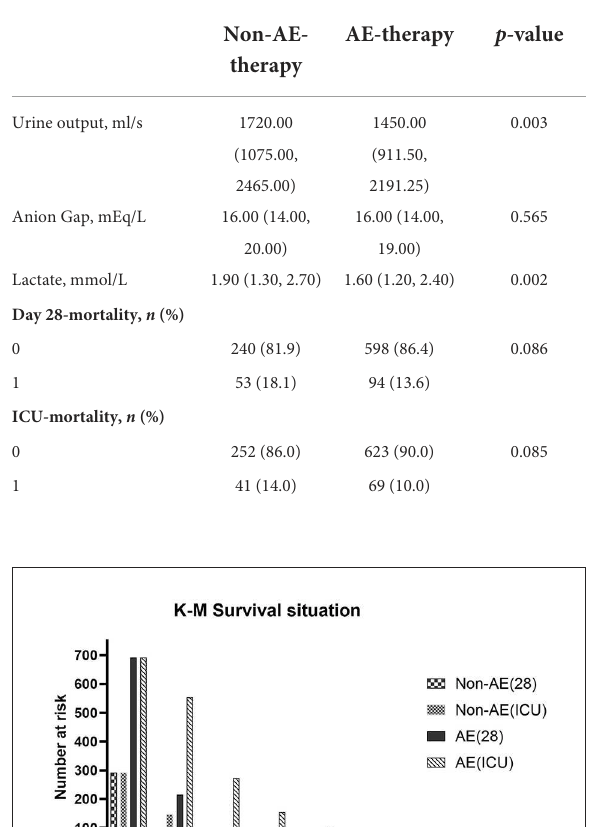
TABLE 2 Analysis of the associations between AE-device therapy and